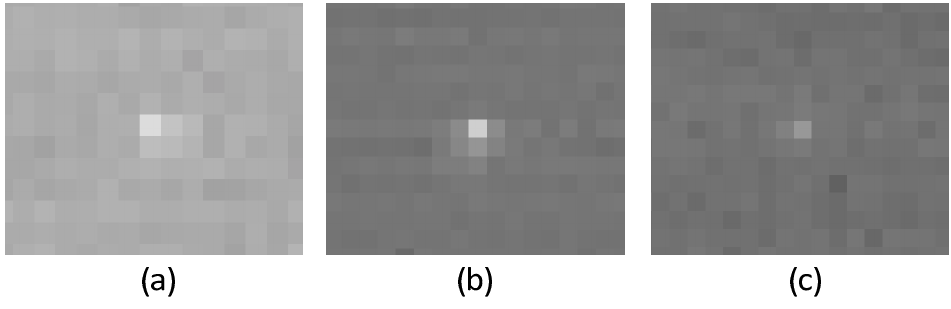
Figure 13. Hip2840 detection results. ( a ) No filter, ( b ) 1.3 um filter, ( c ) 1.5 um filter.